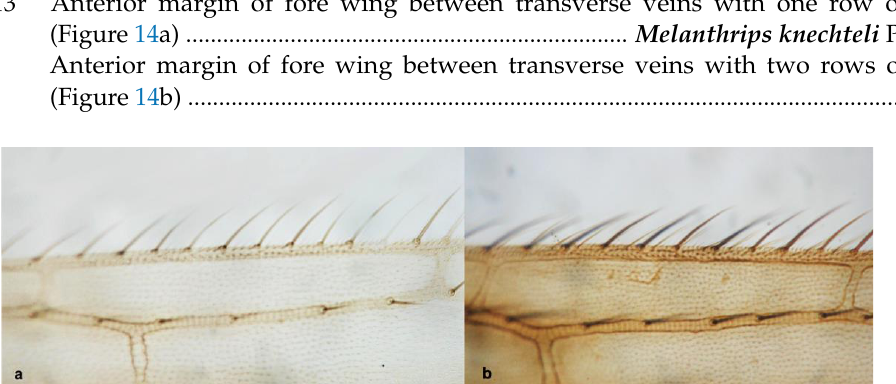
Figure 14. Fore wing: ( a ) with anterior margin between transverse veins with one row of setae; ( b ) with anterior margin between transverse veins with two rows of setae. 14 Hind tibia with one long seta (Figure 15a) ........................ Melanthrips fuscus (Sulzer) Hind tibia with two long setae (Figure 15b) ..................... Melanthrips lybicus Priesner